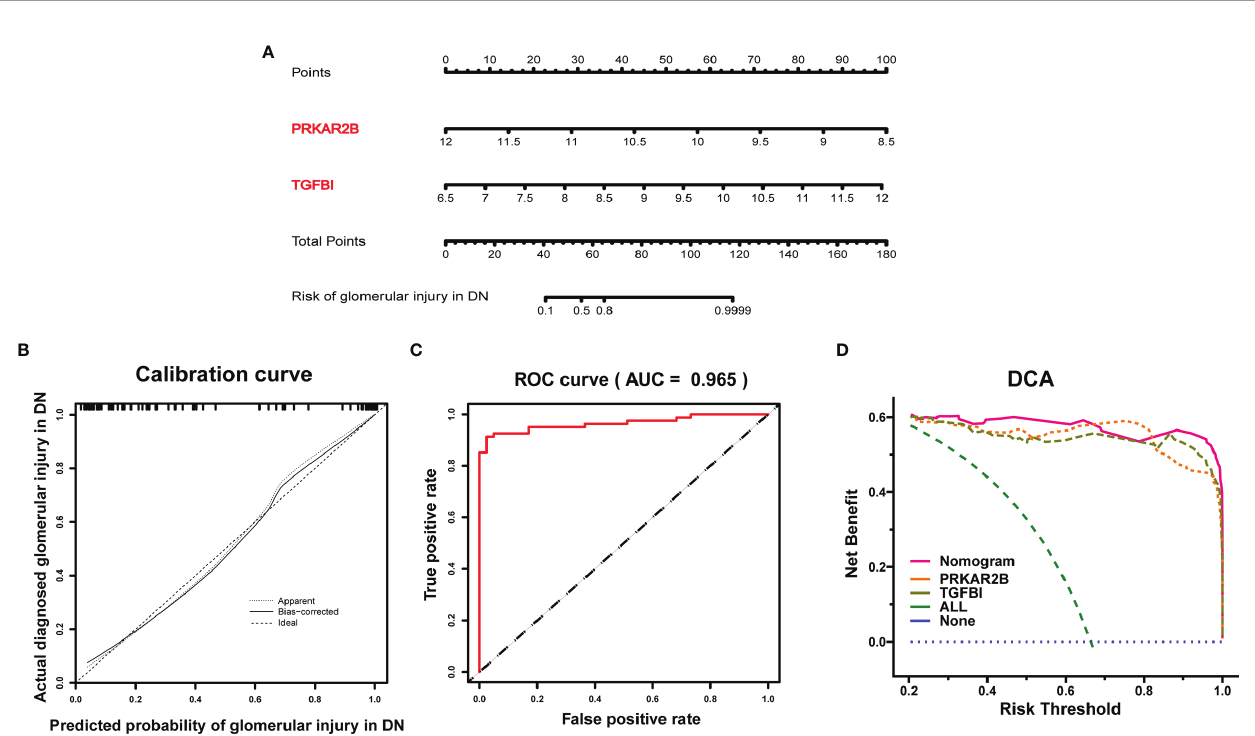
FIGURE 5 | Establishment of the diagnostic model in the GDN training cohort. (A) Nomogram for the diagnostic model of glomerular injury. (B) Calibration curve. (C) ROC curves to evaluate the discrimination ability. (D) DCA for the diagnostic